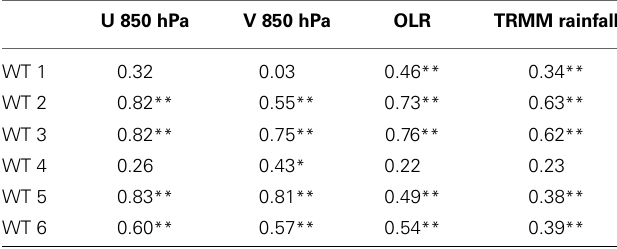
Table 3 | Pattern correlation between the interannual and sub-seasonal anomalies associated with each WT shown in Figure